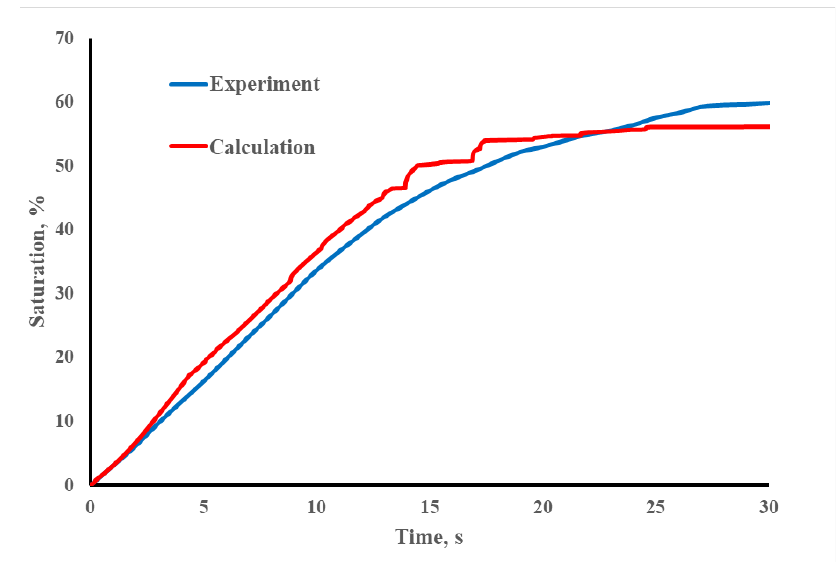
Figure 15. Time-dependent saturation of the microchip with